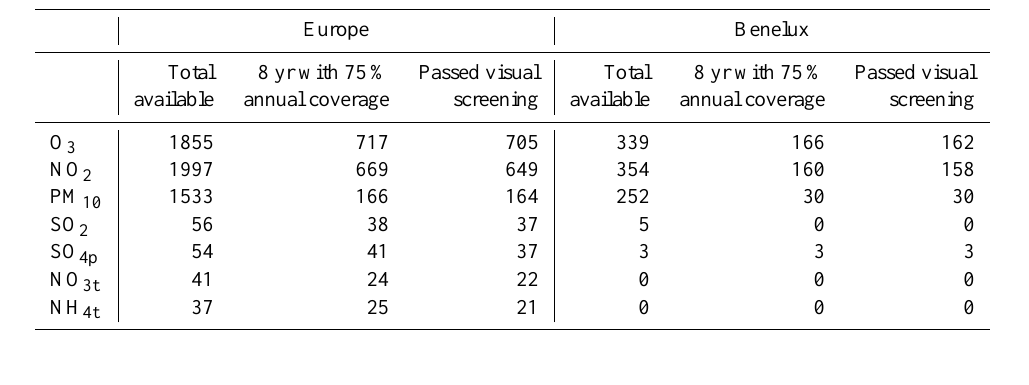
Table 1. Number of available in-situ surface records obtained from the AIRBASE repository (O 3 , NO 2 , and PM 10 ) or the EMEP network (SO 2 , SO 4p , NO 3t , and NH 4t ) before and after applying the quality check criteria, and for both the whole European domain and the Benelux hotspot.